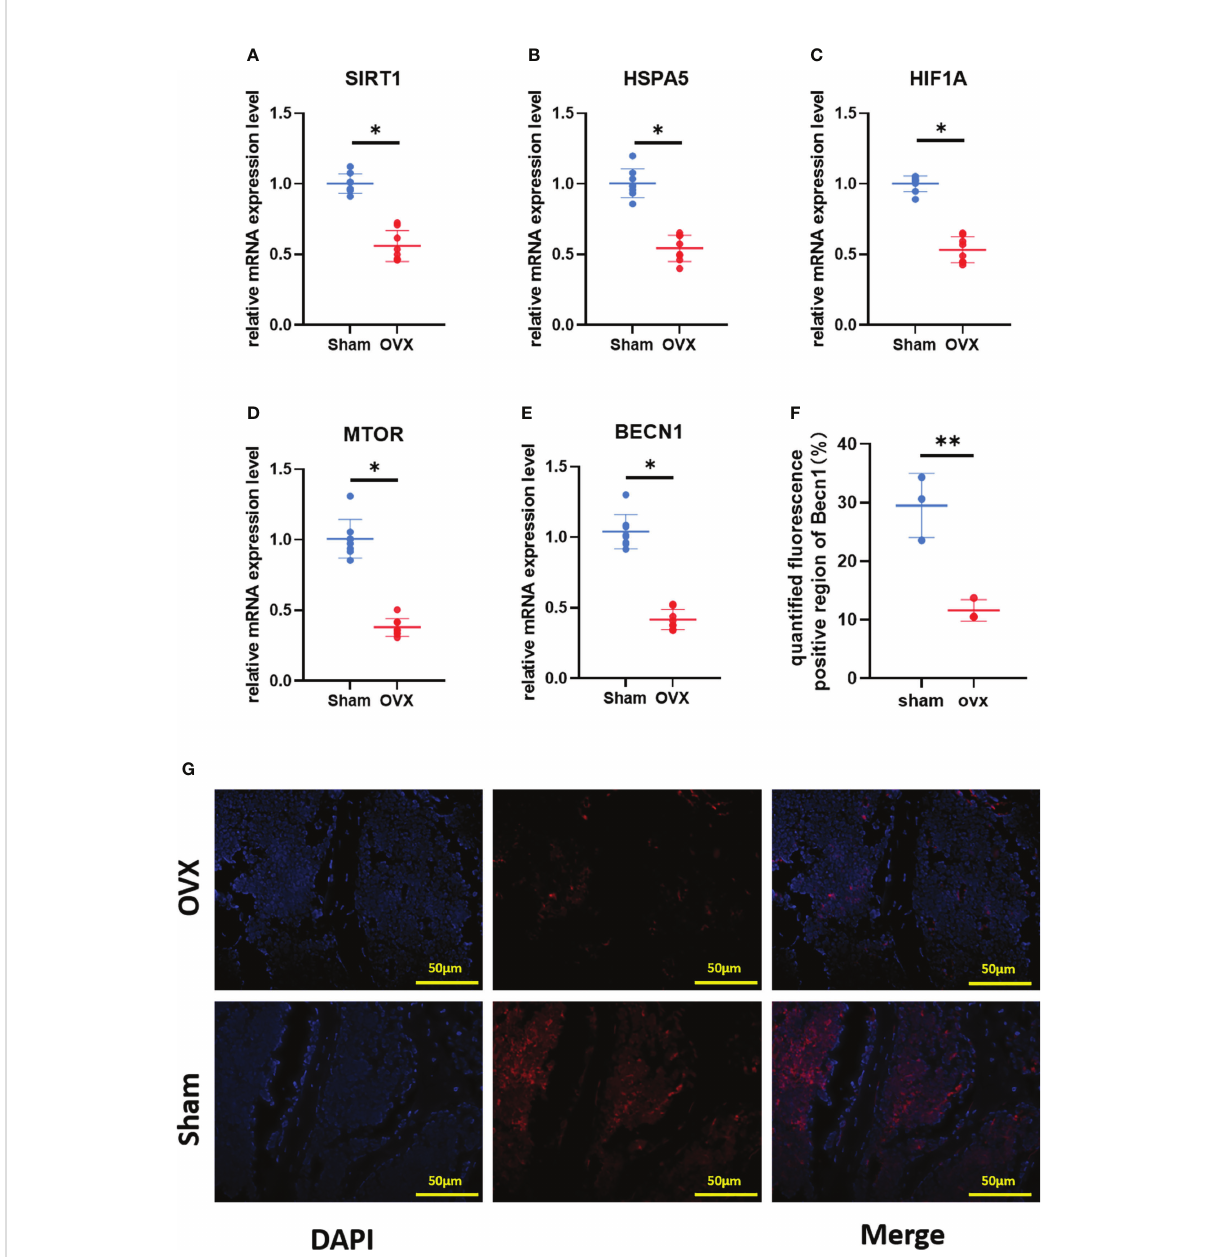
FIGURE 8 Validation of key Ferr-DEGs in vivo . (A – E) The mRNA expression level of Ferr-DEGs ( Sirt1 , Hspa5 , Mtor , Hif1a and Becn1 ) in Sham and OVX group. (F) Quantitative analysis of fl uorescence intensity. (G) Immuno fl uorescence staining of BECN1. (The data are expressed as the mean ± sd *P < 0.05, **P <